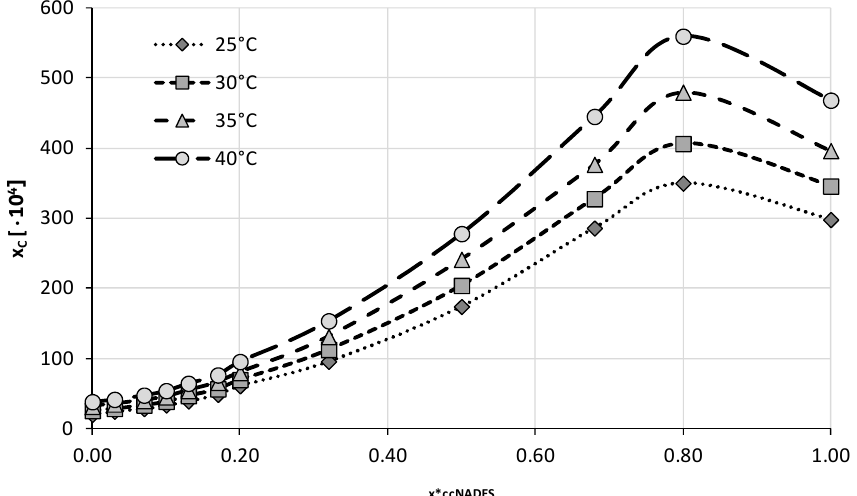
Figure 4. Mole fraction solubility of caffeine in mixtures of water and ccNADES comprising choline chloride and glycerol in 1:2 molar ratio. On the abscissa, x* ccNADES represents the mole fractions of the ccNADES in solute free binary solutions.